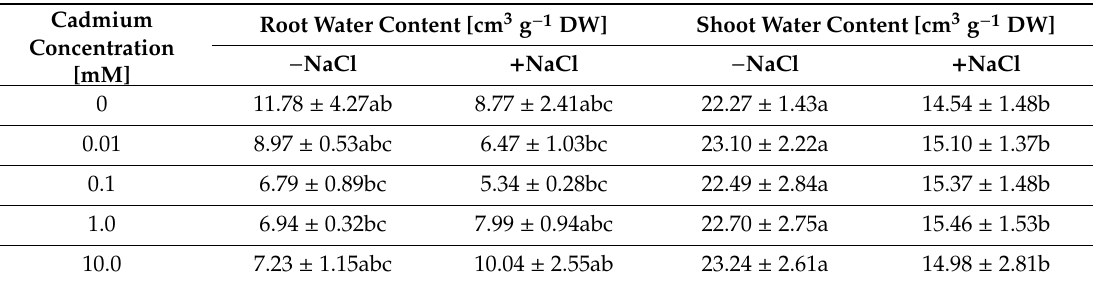
Table 2. Root and shoot water content of soil-grown NaCl-untreated ( − NaCl) and salt-stressed ( + NaCl) M. crystallinum plants subjected to the elevated concentrations of Cd and control.